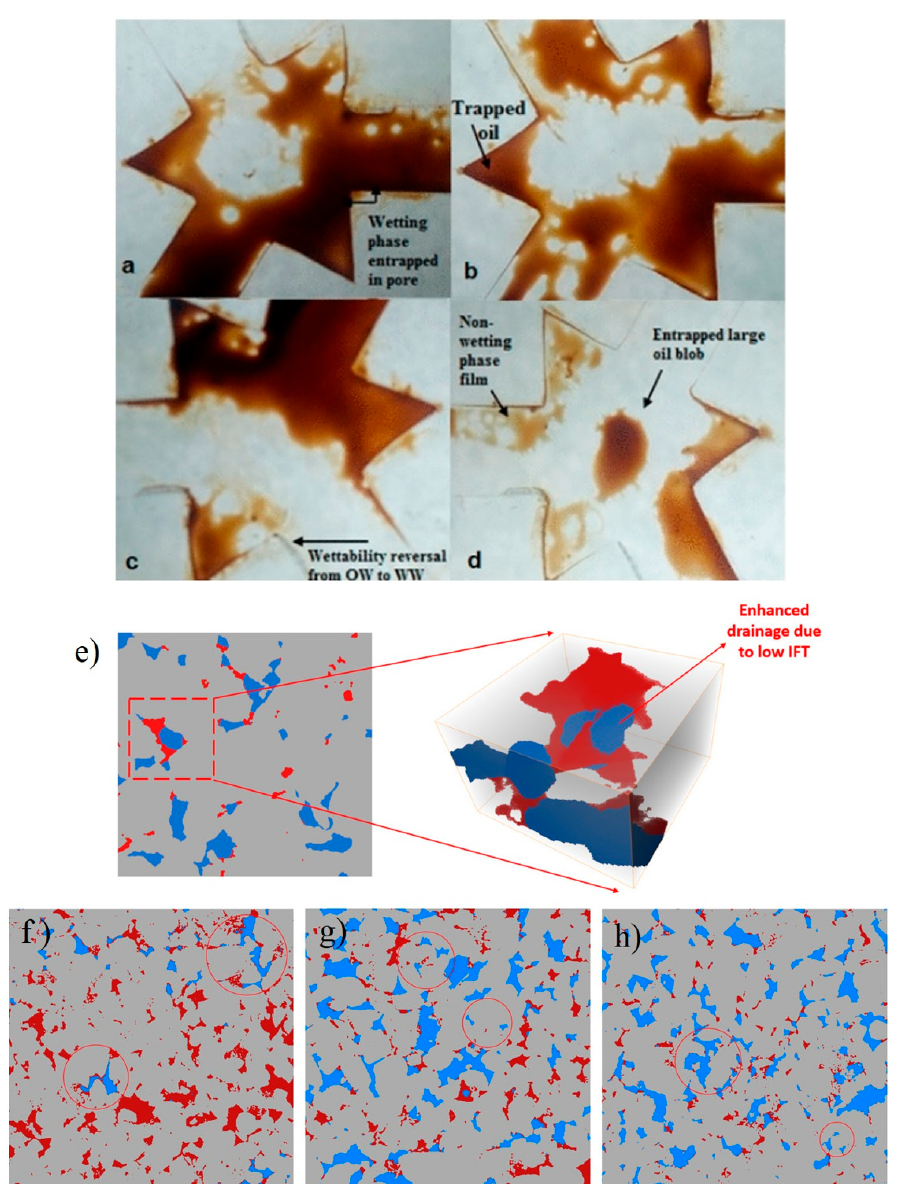
Figure 7. Digital microscope images of solution injection in the micromodel showing the pore-scale configuration and distribution of wetting and non-wetting phases within an initially preferential oil-wet medium for ( a and b ) surfactant solution and ( c and d ) surfactant and NP solution [60]; ( e ) 3D illustration of enhancement of the drainage process after a complex nanofluid injection and ( f – h ) 2D cross-sectional fluid occupancies for nanofluids in oil-wet systems [89].